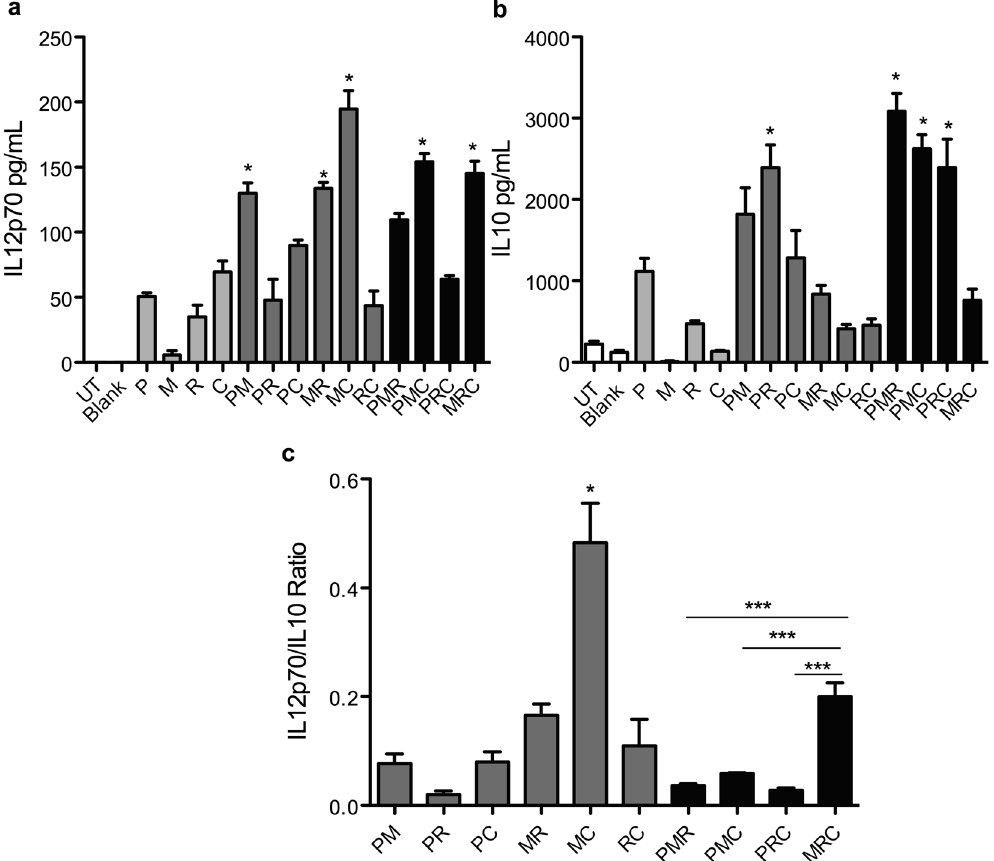
Figure 2. Synergistic stimulation of IL12p70 and IL10 production by different PLP combinations. BMDCs were exposed to medium alone (UT) or treated with blank PLP (Blank), 100 ng mL − of PLP-Pam3CSK4 (P), 10 ng mL − of PLP-MPLA (M), 1 μ g mL − of PLP-R837 (R), or 100 ng mL − of PLP-CpG (C), individually or in combinations of 2 or 3 for 24 h. Cell-free supernatants were harvested and assayed for ( a ) IL12p70 or ( b ) IL10 by ELISA. Ratio of IL12p70 to IL10 for each combination is shown in ( c ). Data from one representative experiment out of three are shown as mean ± SEM of 3 replicates. Statistical analysis was performed by 1 way Anova followed by Tukey’s multiple comparison tests. ( a and b ) * Represents significant and synergistic differences from individual components. ( c ) * Represents significant difference (p < 0.05) from all groups. *** (p <